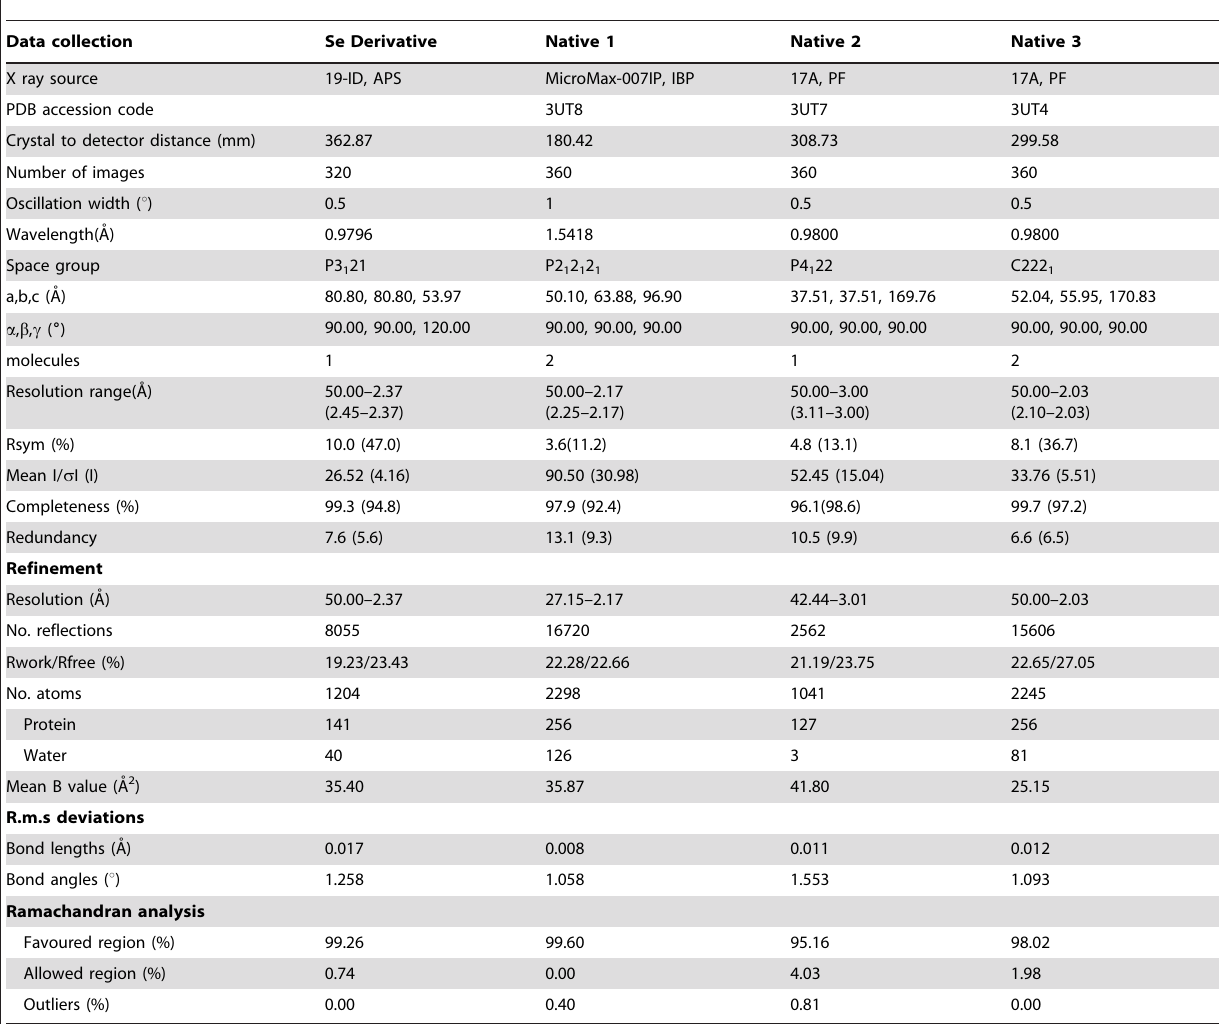
Table 4. Data collection and refinement